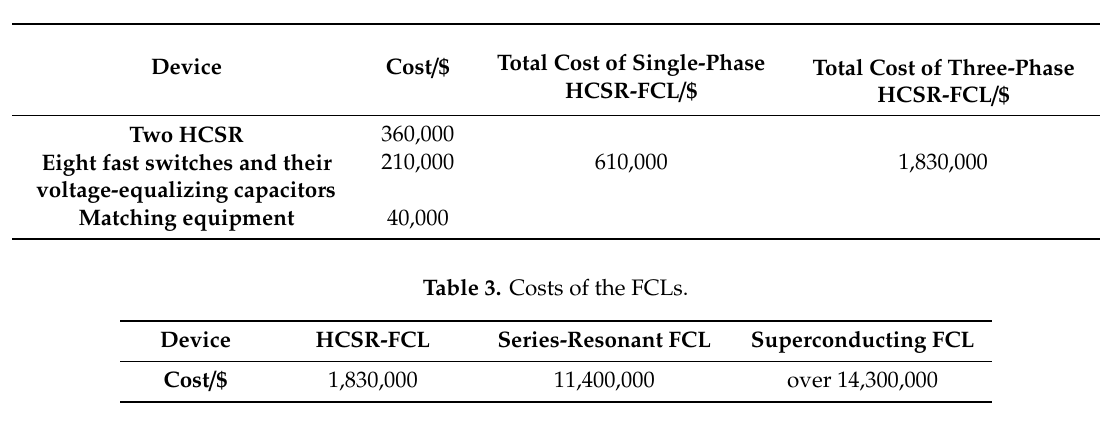
Table 2. Cost of the HCSR-FCL.